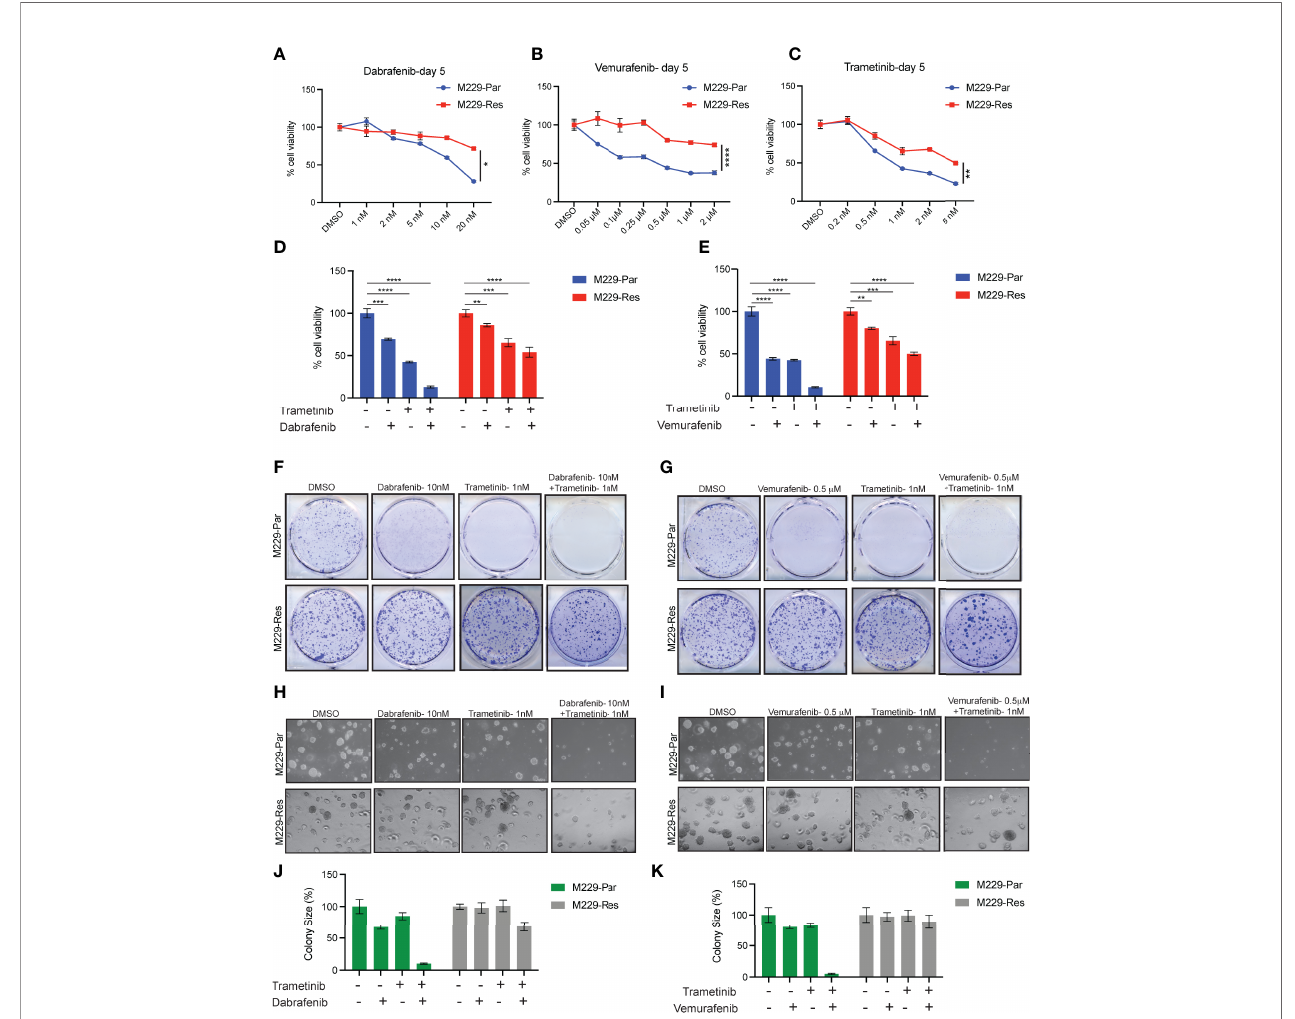
FIGURE 1 | Effects of MAPK pathway inhibitorson M229-Par and M229-Res melanoma cellgrowth. (A – C) The indicated melanoma cell lines were treated with the indicatedconcentrationsof dabrafenib,vemurafenib,ortrametinibfor 5 daysandsubjectedto MTT assays. Cellviability isplottedrelative to DMSO-treated cells. (D) The indicatedmelanoma celllines were treated with either 10 nM dabrafenib or 1 nMtrametinib,aloneorin combination,for 5 days andsubjectedto MTT assays. Cellviability is plotted relative to DMSO-treated cells. (E) The indicated melanomacelllines were treatedwith either 0.5 µMvemurafenib or 1 nMtrametinib,aloneorin combination,for 5 daysandsubjectedto MTT assays. Cellviability isplottedrelative to DMSO-treated cells. (F) The indicatedmelanoma celllines were treated with either 10 nM dabrafenib or 1 nM trametinib,alone orin combination,and subjected to clonogenic assays. Representativeimages are shown. (G) The indicatedmelanoma celllines were treated with either 0.5 µMvemurafenib or 1 nMtrametinib,aloneorin combination,and subjected to clonogenic assays. Representative images are shown. (H) The indicated melanoma celllines were treated with either 10 nM dabrafenib or 1 nMtrametinib,aloneorin combination,and subjected to soft-agar assays. Representative images are shown. (I) The indicatedmelanoma celllines were treated with either 0.5 µMvemurafenib or 1 nMtrametinib, alone or incombination, andsubjectedto soft-agar assays. Representative images are shown. (J – K) Relativecolony sizes in the images shown inpanels (H, I) , respectively. Data represent the mean ± standard error of three biological replicates. ns= not signi fi cant, * p < 0.05, ** p < 0.01, *** p < 0.001, **** p <